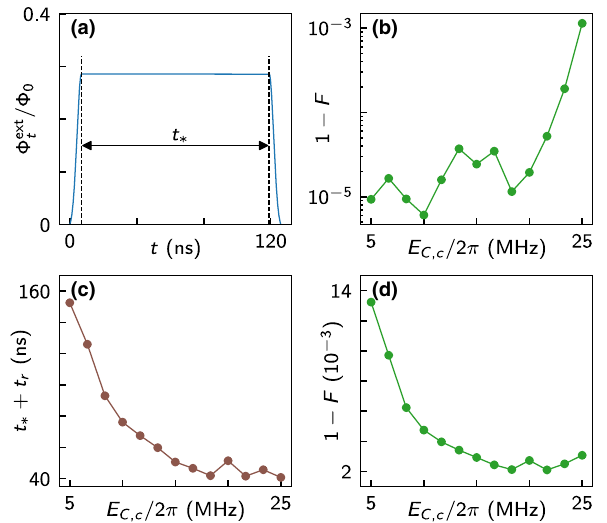
FIG. 6. The performance of the CZ 10 φ gate. (a) A typical flux ( t ) , for the CZ 10 pulse, (cid:6) ext (cid:3) (cid:3) (cid:4) (cid:4) φ gate as described by Eq. (20). The wait t (cid:3) (cid:3) ↔ 0 t , 3 p is t ∗ . The ramp up or time near the anticrossing 1 t , 0 p down time of the flux pulse is t r / 2. (b) The optimized gate error, 1 − F , in the absence of 1 / f flux noise and qubit-relaxation errors obtained from Eq. (21) versus the coupling capaci- tance, E C , c . The system parameters are ( E J , t , E J , p , E C , t , E C , p ) = 2 π( 12, 2.7, 0.2, 0.15 ) GHz, and n g , p = 0. (c) The optimized gate time, t ∗ + t r , versus the coupling capacitance, E C , c . The system parameters are the same as in (b). (d) The optimized gate error, 1 − F , in the presence of 1 / f flux noise and qubit-relaxation errors obtained from Eq. (26), as a function of the coupling capacitance, E C , c . The system parameters are the same as in = (cid:15) ( odd ) = 1 / T = (b). The noise parameters are (cid:15) ( even ) 1 , with T 1 1 1 20 μ s [62]. Moreover, A 1 / f , (cid:6) = 5 μ(cid:6) 0 [64] and λ 1 / f = 4